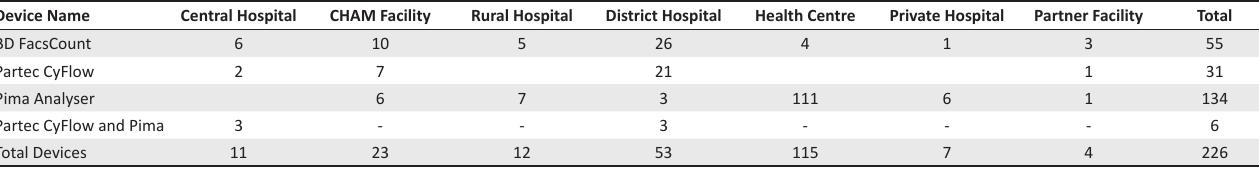
FIGURE 1: Distribution of PCR laboratories and early infant diagnosis point-of-care testing in Malawi. (a) Red balloons show the nine conventional PCR laboratories. (b) Red balloons show the seven pilot sites for early infant diagnosis point-of-care TABLE 2: Distribution of laboratory and point-of-care CD4 testing in Malawi